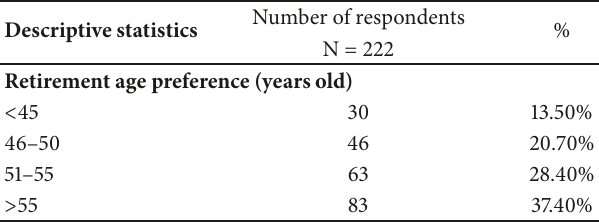
Table 1: The characteristics of the study